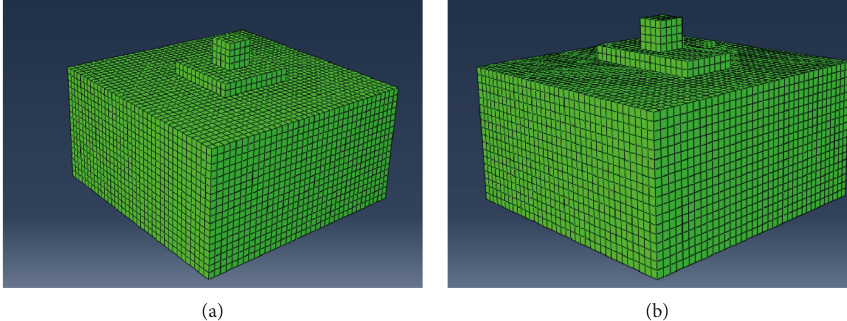
Figure 2: Concrete footing-soil configurations. (a) Configuration-1. (b) Configuration-2.